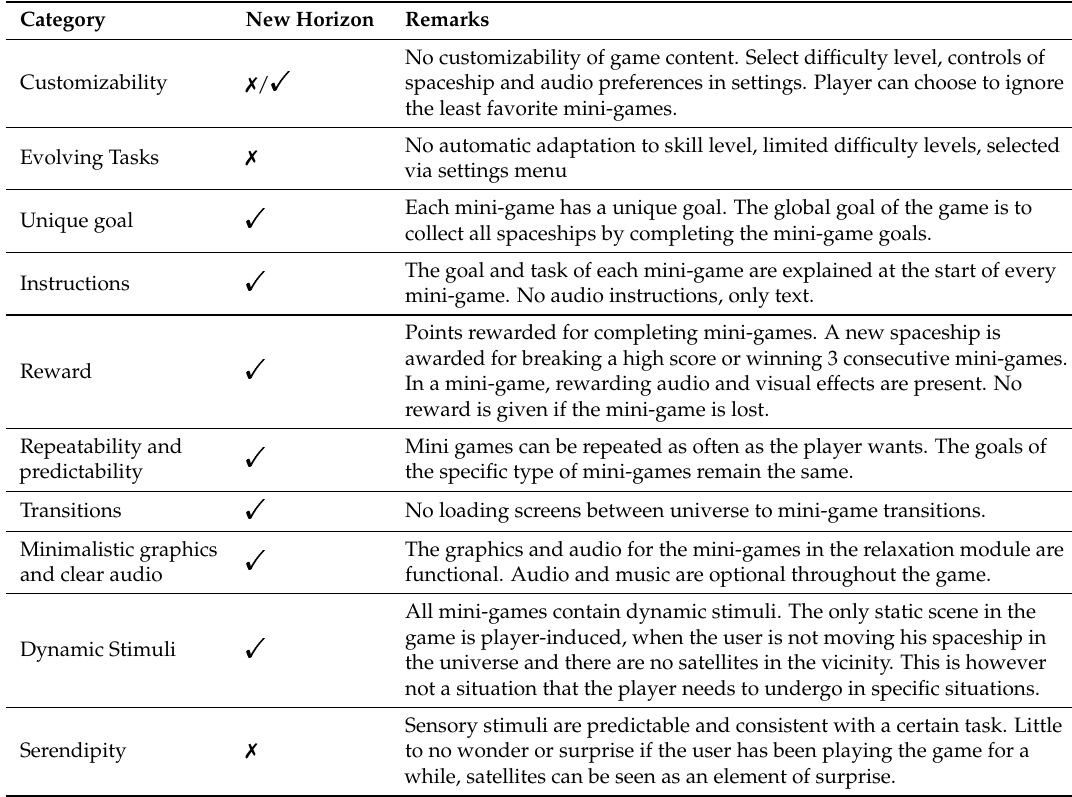
Table 7. Analysis of the design guidelines integrated in New